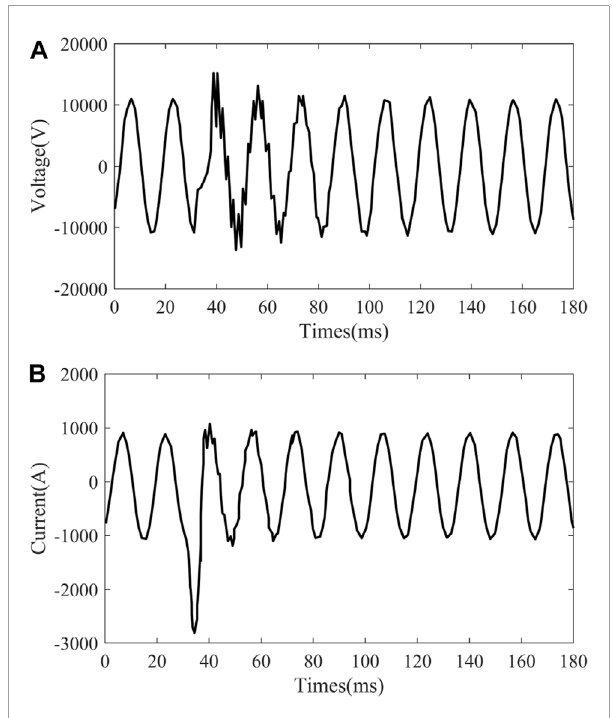
FIGURE 1 Waveform from a single-phase incipient fault in underground cable. (A) Voltage wave form of fault phase, (B) current wave form of fault phase.